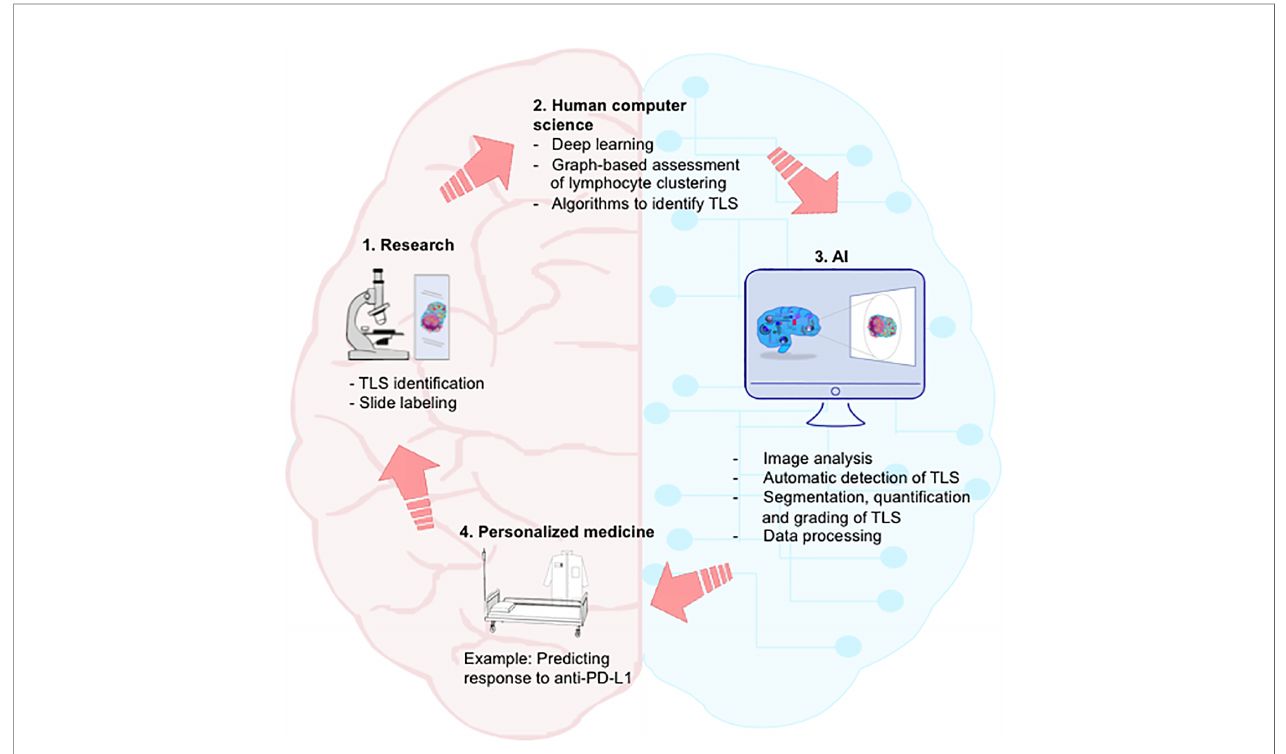
FIGURE 4 | Integration of AI in the continuum of medicine. Streamlined dialogue between human and computer may accelerate path from laboratory discovery on TLS to clinical application and personalized medicine. Step 1. Researchers and clinicians identify TLS on labeled slides. Step 2. Computer scientists develop algorithms allowing machine-learning for automatic identi fi cation of TLS. Step 3. AI performs segmentation, quanti fi cation and grading of TLS, as well as big data processing. Step 4. By integrating computerized medical data into the therapeutic decision, anticipation of clinical responses (in particular following anti-PD-L1 therapy) and development of personalized medicine would become possible. AI, arti fi cial